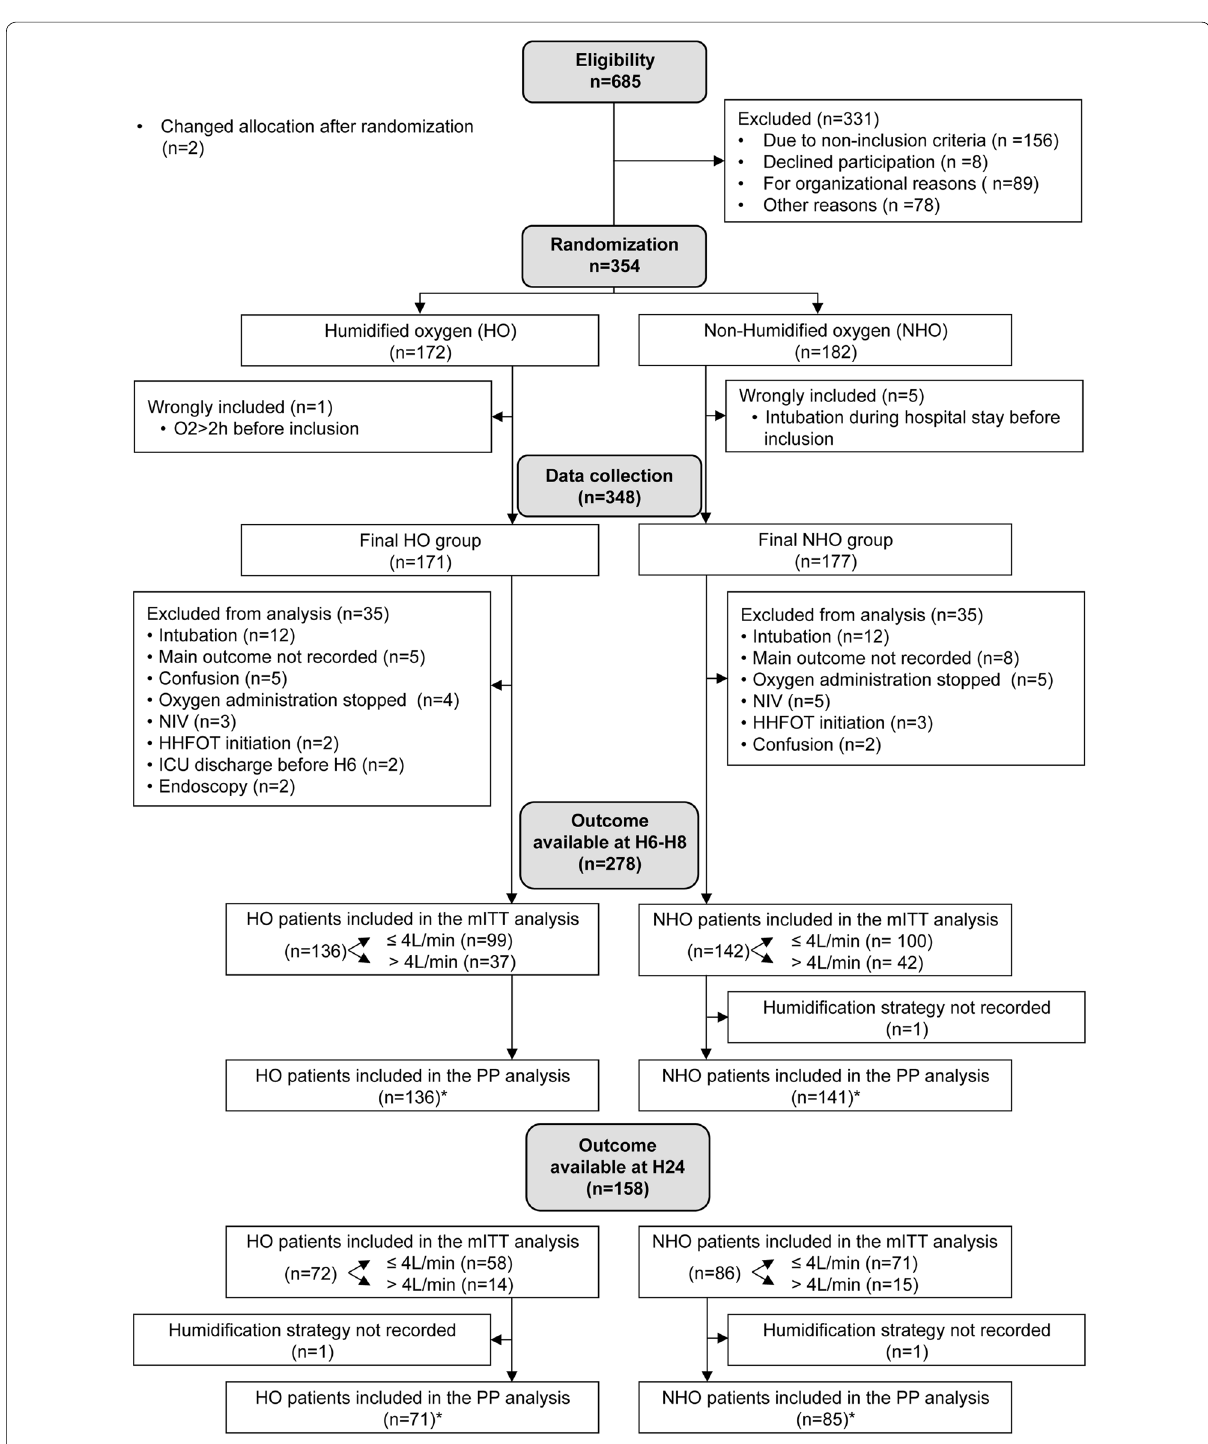
Fig. 1 Study flowchart. NIV noninvasive ventilation, HHFOT humidified high flow oxygen therapy, ICU intensive care